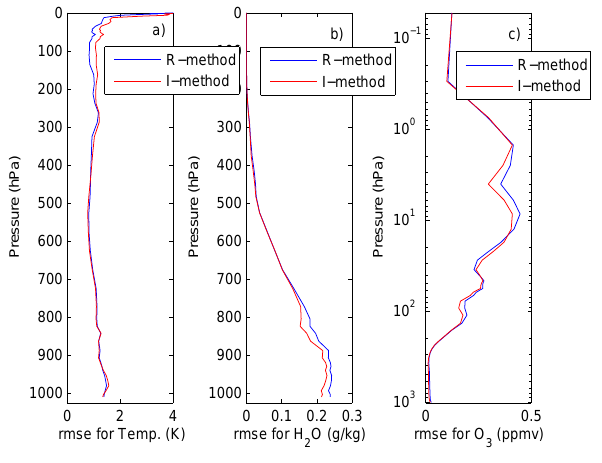
Figure 8. Results for the case study in simulation and for ( N = 300 , x cm). The figure shows the retrieval performance expressed in terms of root mean square error (rmse) for (a) temperature, (b) water vapour and (c) ozone. The results applies to high-latitude-winter IASI